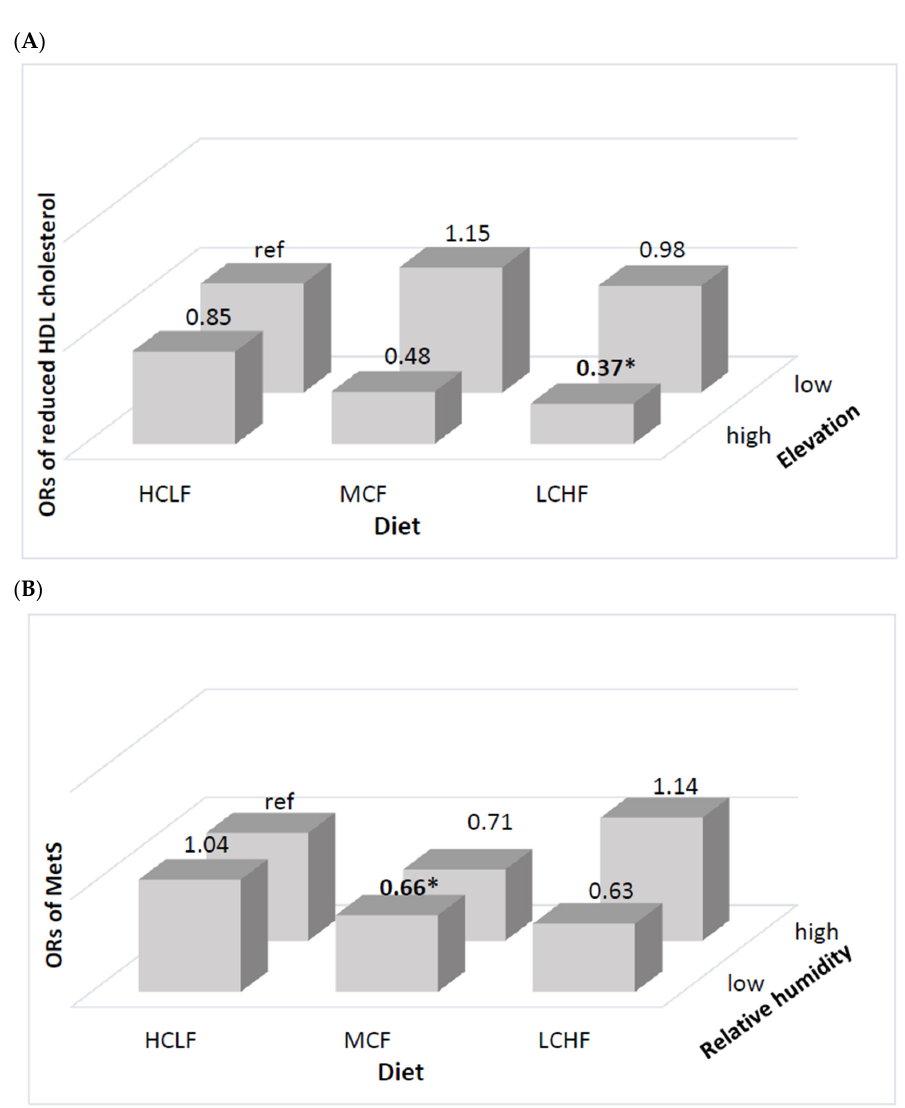
Figure 2. Multivariable-adjusted odds ratios for MetS in Ecuadorian women according to diet and physical environment. ( A ) Odd ratios for reduced HDL cholesterol by the status of carbohydrate